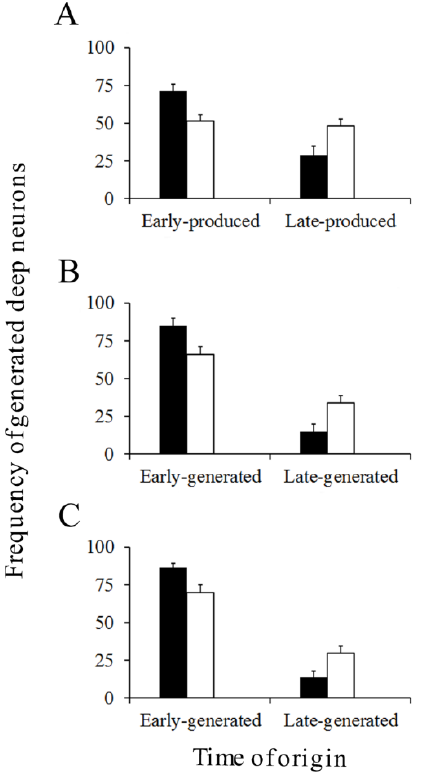
Figure 9. Percentage of early and late-generated deep nuclei neurons scored at the level of the fastigial ( A ), interpositus ( B ), and dentate ( C ) nuclei. Black columns indicate animals injected with bromodeoxyuridine and white columns animals administered with [ 3 H]TdR. Values are expressed as mean ± SEM.